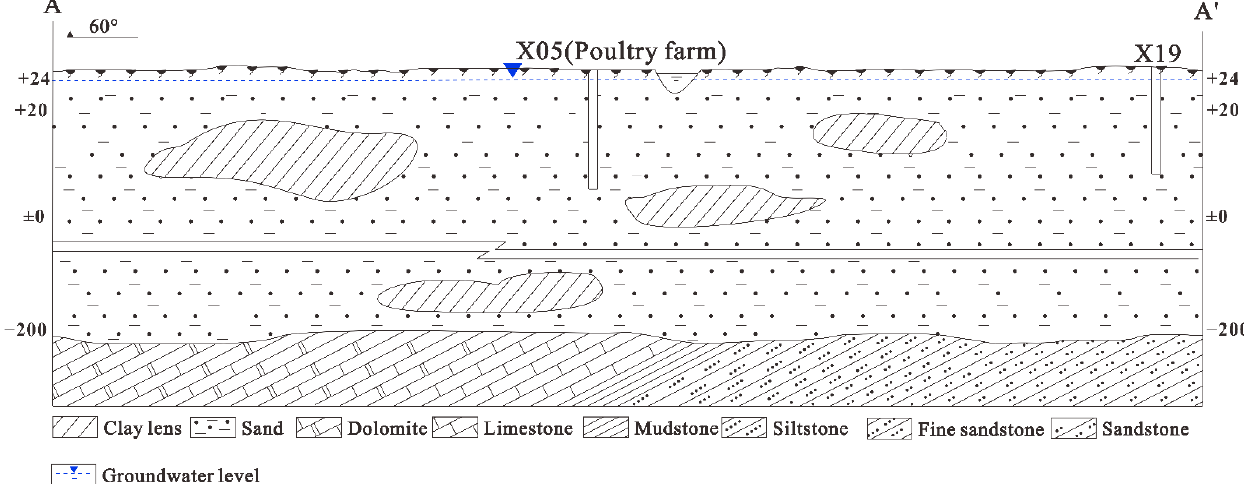
Figure 2. Simplified hydrogeological cross ‐ section A − A ′ .